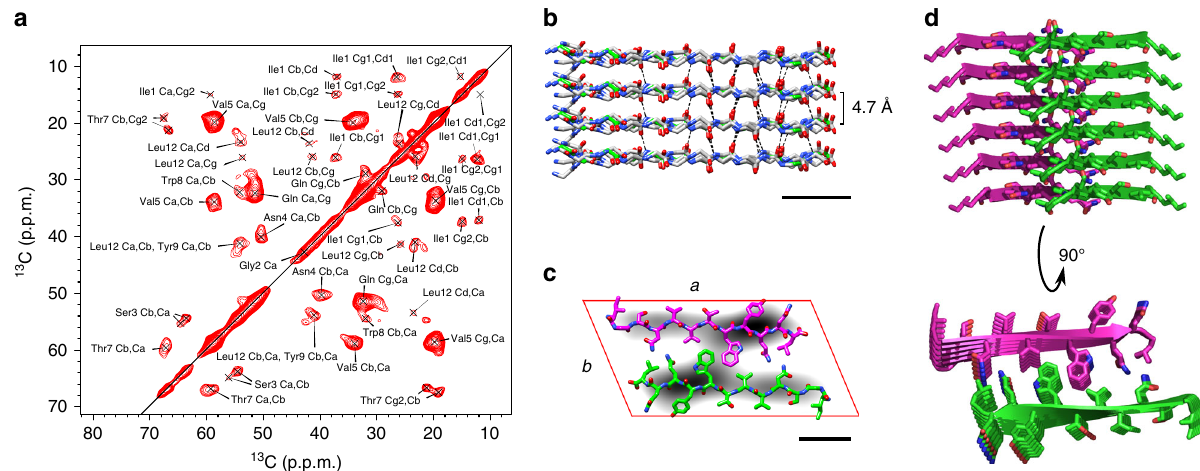
Fig. 2 Protomer conformation revealed by ss-NMR. a The 2D 13 C – 13 C proton-driven spin diffusion spectrum shows the cross-peaks between aliphatic carbon atoms. b Backbone model of the cross- β sheet implementing Φ / Ψ angles as predicted by the program TALOS + 29 (scale bar, 1 nm). c Averaged parallelograms of morphologies I – V (gray) superimposed with a peptide dimer (green, magenta) as obtained by NMR. The placement of the peptides followed the considerations described previously for morphology I 8 (scale bar, 1 nm). d Side view and top view of a six-layer stack illustrating the structure of a PF. Side-chain conformations were not determined by experiments and represent only conformations that are compatible with the packing shown